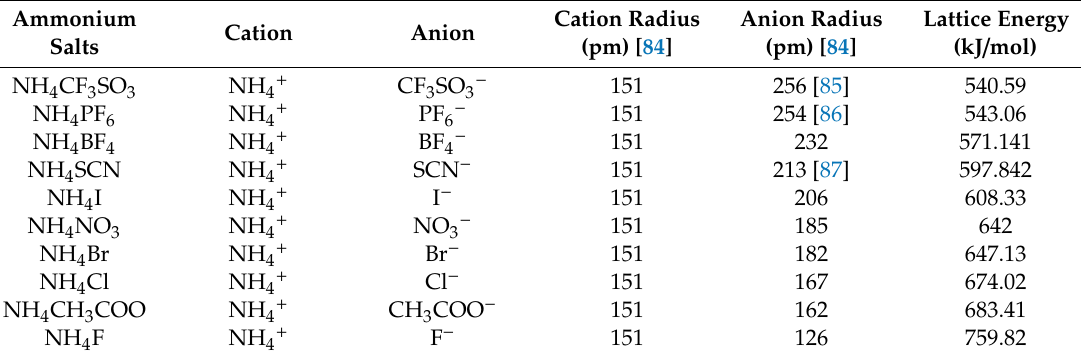
Table 5. Lattice energy for some of the ammonium salts.